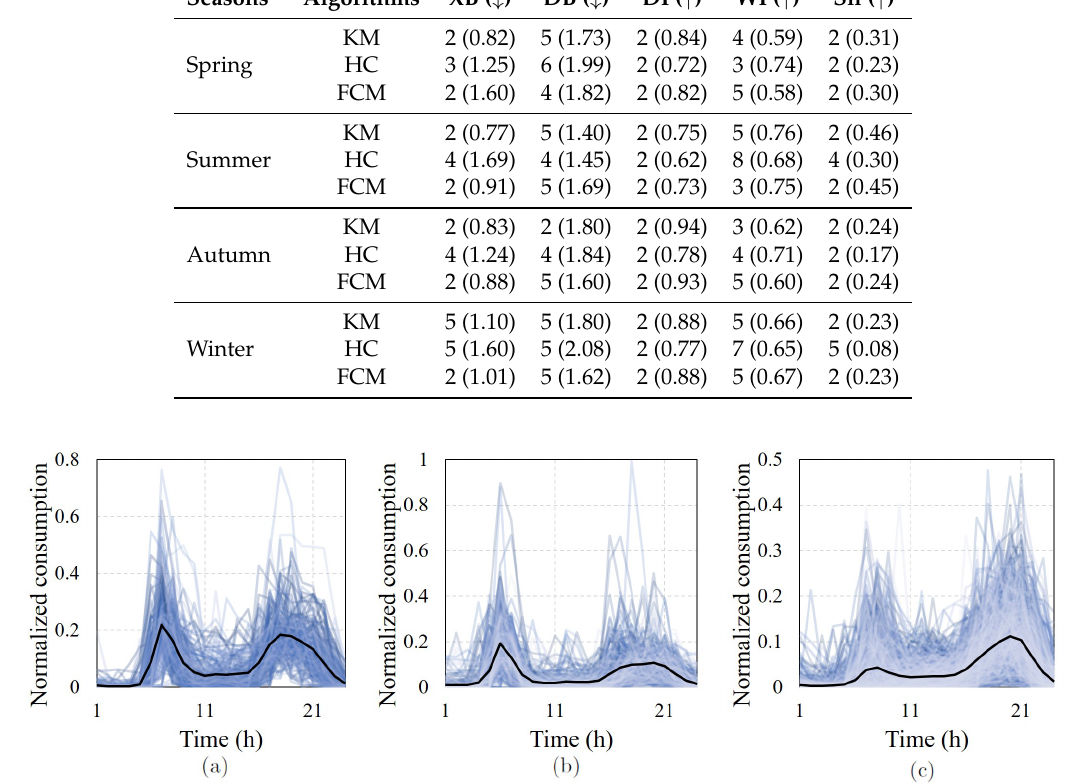
Figure 7. Spring profiles for three clusters using HC: ( a ) Cluster 1; ( b ) Cluster 2; ( c ) Cluster 3.